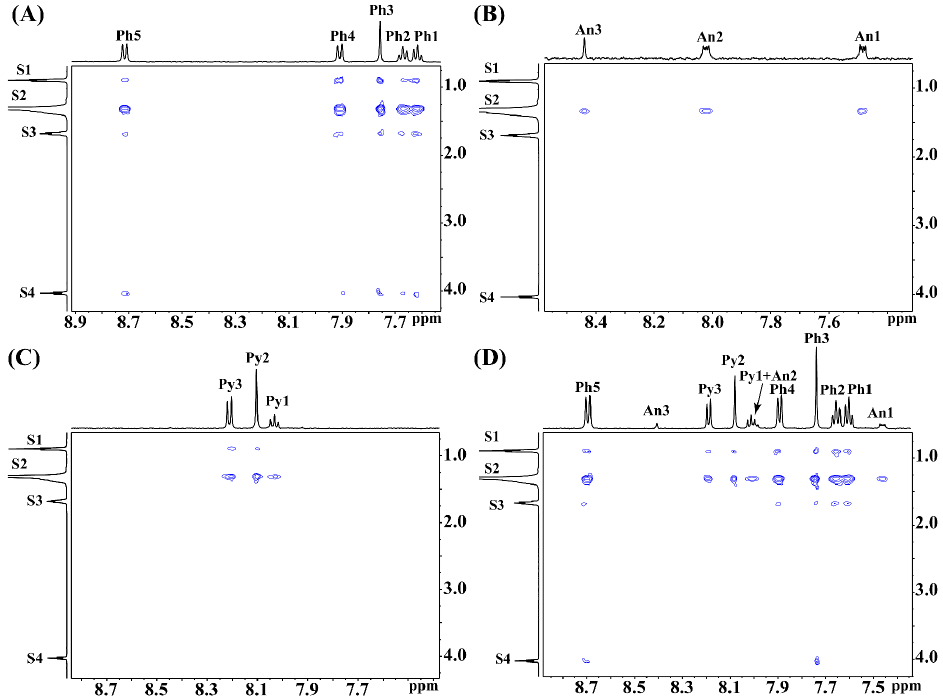
Figure 12. Partial NOESY spectra of single Phe ( A ), Ant ( B ), Pyr ( C ) and ternary Phe-Ant-Pyr systems ( D ) solubilized by 120 mM SDS micelles with the mixing time of 1 s.